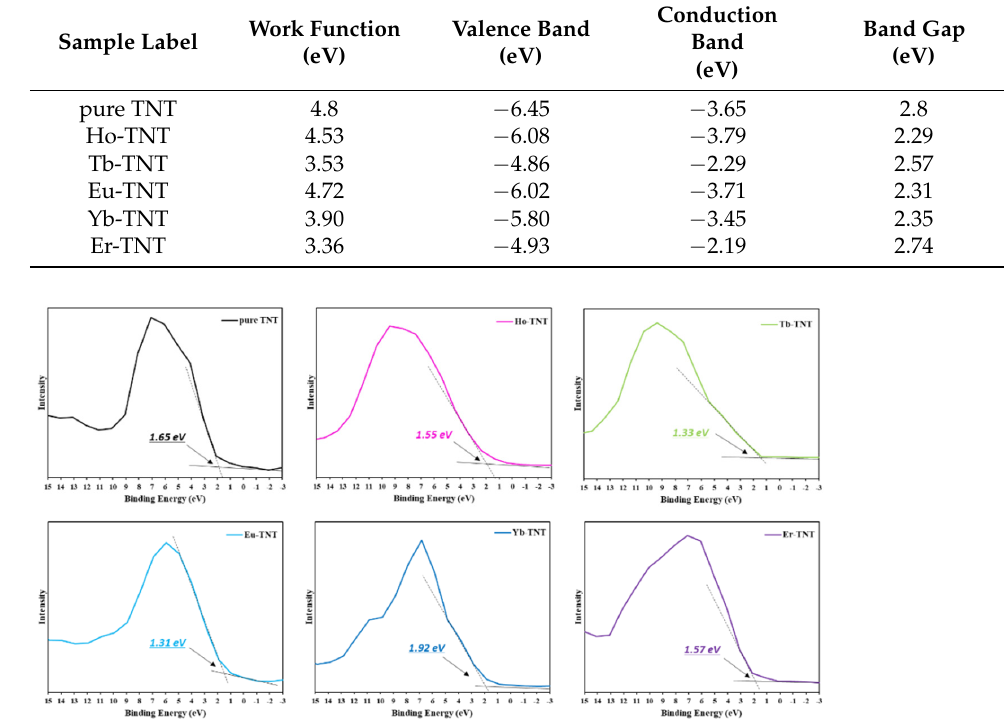
Figure 3. UPS spectra of the secondary electron with the onset highlighted in the graph to determine the work function. TNT and lanthanide-doped TNT. Table 2. Band structure parameters of doped TNTs.